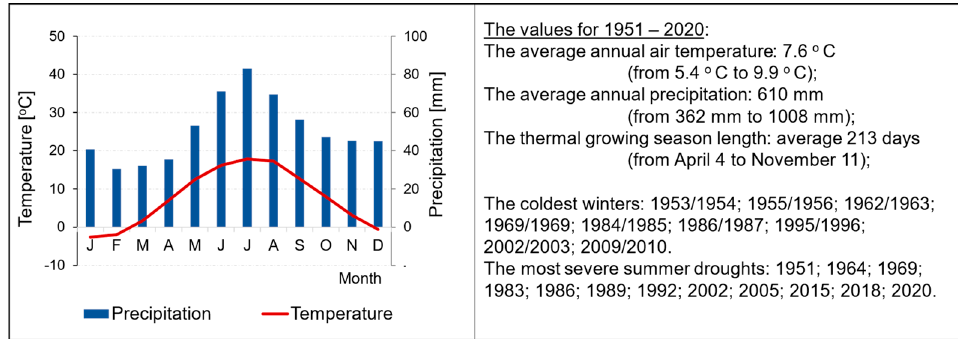
Figure 2. Climatic diagram (for the years 1951–2020) and the selected climatic characteristics for the study area (based on the data obtained from the Polish Institute of Meteorology and Water Management). Climatic characteristics were determined on the basis of the following criteria: thermal growing season: period from when daily temperatures are ≥ 5 ◦ C for >5 days and when daily temperatures fall to <5 ◦ C for 10 days [37]; the coldest winters: the mean temperatures of all the winter months were lower than the long-term mean value by at least 1.5 SD; severe droughts were determined on the basis of the SPEI value [38] calculated for the study